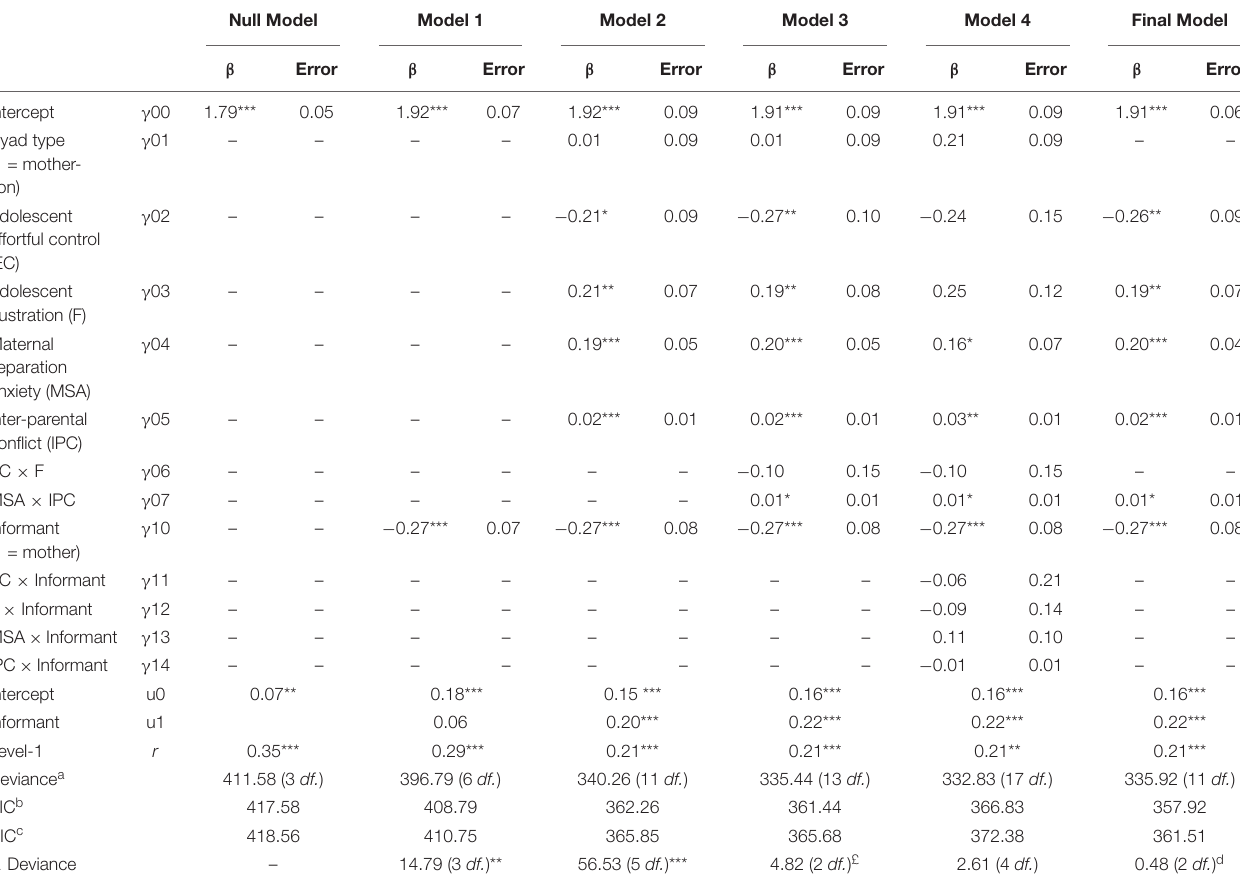
TABLE 2 | Predictors of psychological control as perceived by mothers and